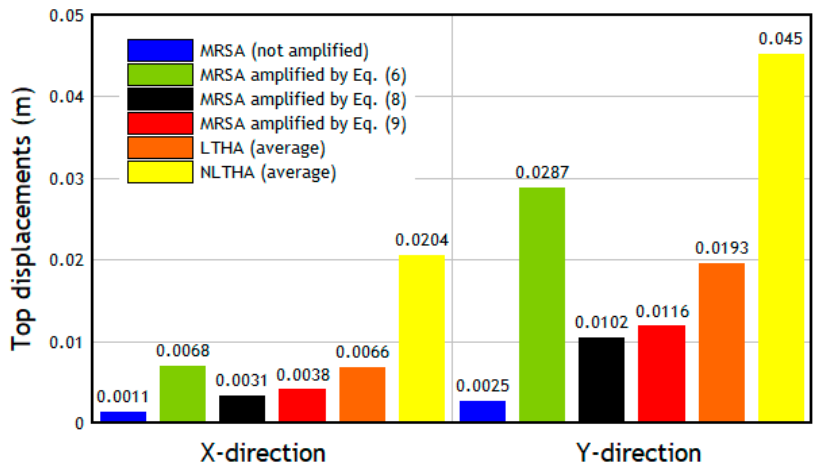
Figure 15. Histogram with the maximum displacements predicted by the different analyses.